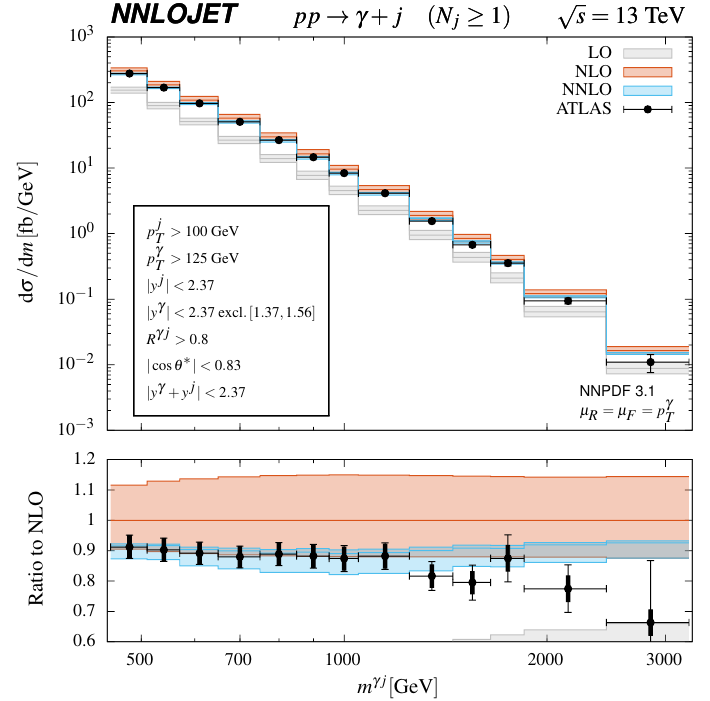
Figure 13 . Invariant mass of the photon leading jet system, at LO, NLO and NNLO. The predictions are compared to ATLAS data